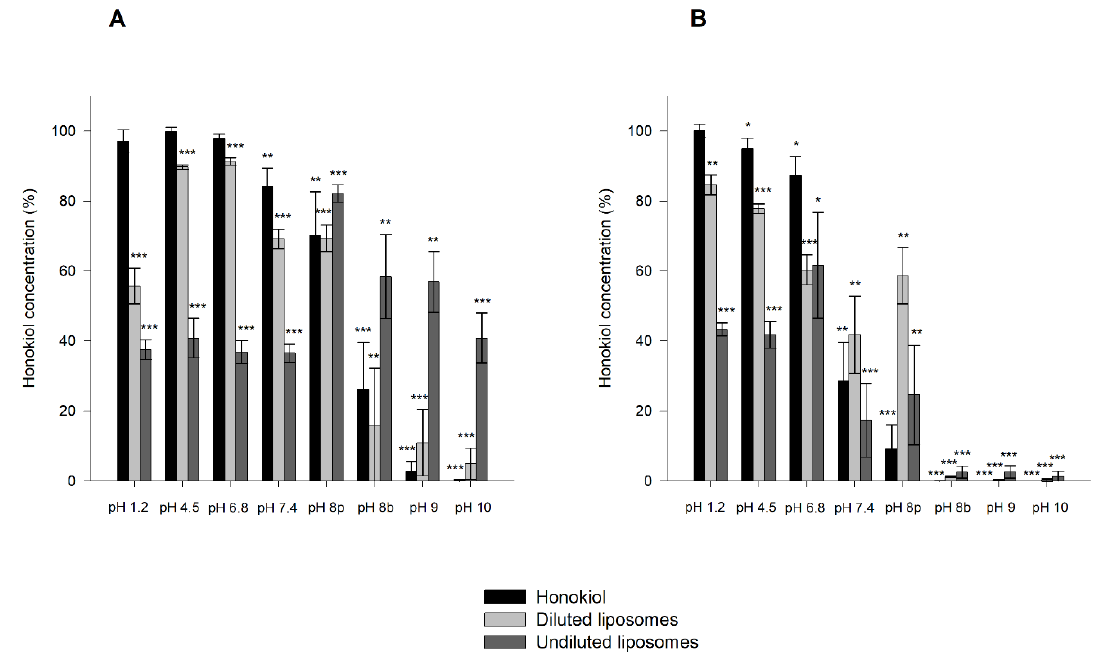
Figure 9. Stability of honokiol and honokiol-loaded liposomes (diluted and undiluted) after 30 days of incubation at room temperature ( A ) and 37 °C ( B ). Data are expressed as the percentage of the initial concentration. pH 8p: phosphate buffer; pH 8b: borate buffer. * p < 0.05, ** p < 0.01, *** p < 0.001.